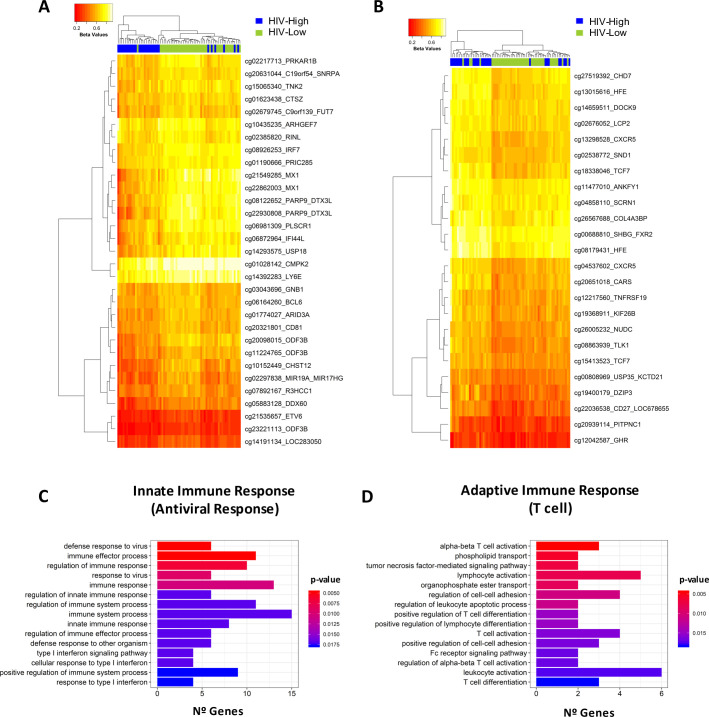
Relevant DMPs for classification in HIV-High and HIV-Low groups.Cluster analyses of the selected CpG positions for the classification of individuals (random forest model). Two clusters are showed in A and B as heatmaps that differentiate HIV-Low from HIV-High subjects. Distances are based on Manhattan and clustering, on complete linkage. Columns represent tested individuals, HIV-High (blue) and HIV-Low (green), and rows depict the Beta-values of the CpGs in each cluster. The colour scale from red to yellow represents from low to high methylation. (C-D) Histogram plots of the Gene Ontology Enrichment Analysis (clusterProfiler R/Bioconductor) for the two identified clusters (A and B) of DMPs. Pathways with the highest significance are shown; the complete output is in S3 Table.